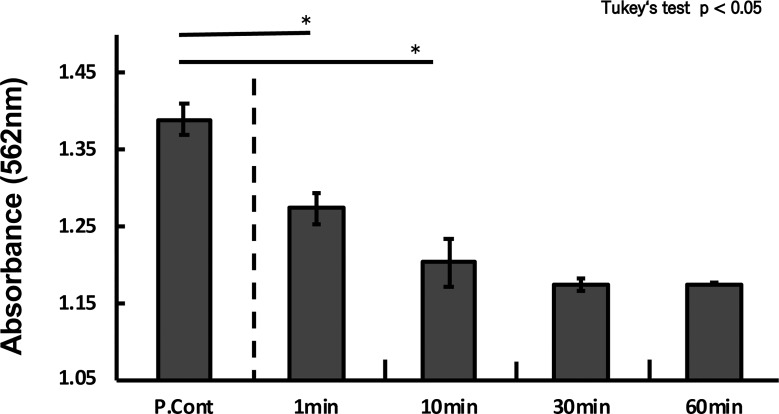
Functional potential of nanoplatinum solutions to decompose albumin.Overall, 10 ppm nanoplatinum solutions were added to 2 mg/mL albumin solutions and allowed to react for 1, 10, 30, and 60 minutes. Protein abundance was measured in the BCA protein assay. (*p < 0.05, Tukey’s test).